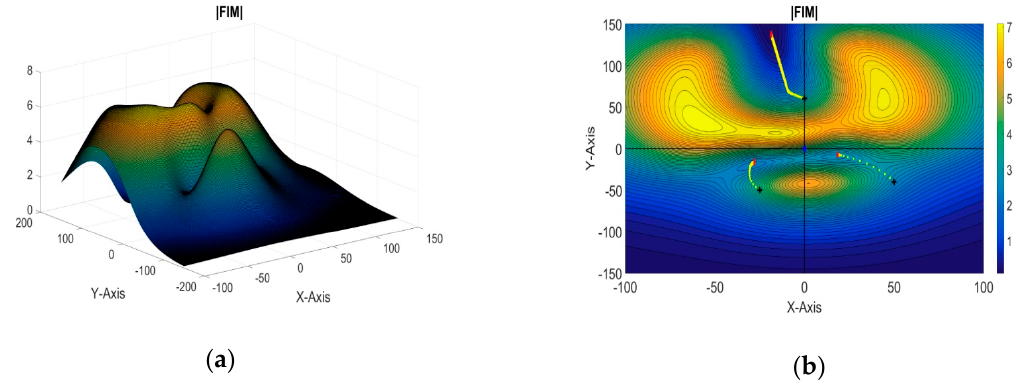
Figure 5. ( a ) 3D plot of the evaluation function (single target: DSP); ( b ) 2D contour plot of the evaluation function (single target: